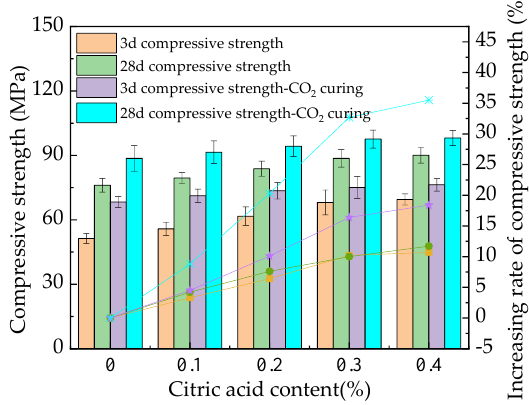
Figure 5. The compressive strength of the MOS paste.